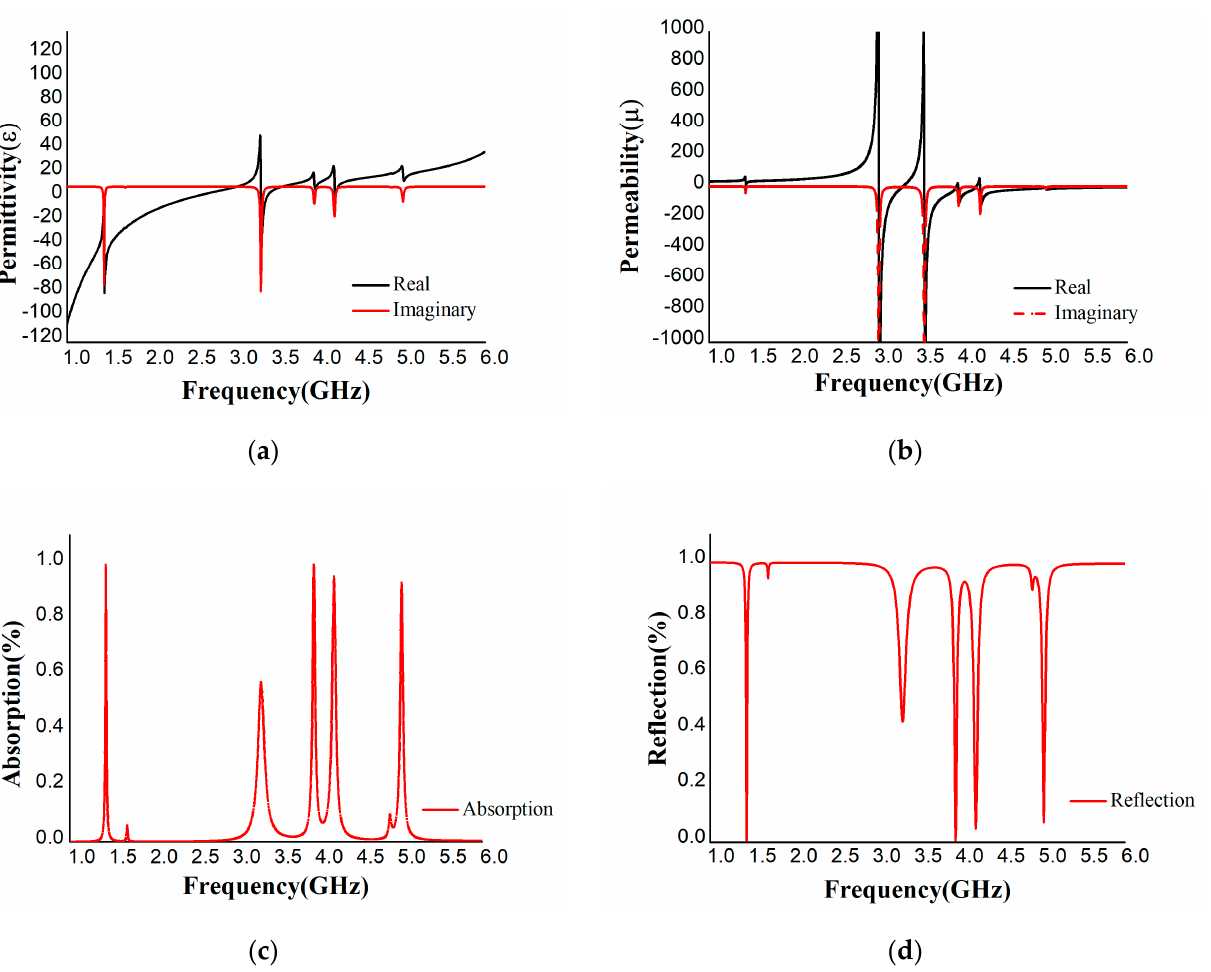
Figure 6. ( a ) Permittivity, ( b ) permeability, ( c ) absorption, and ( d ) reflection of Rogers4450B sub- strate.